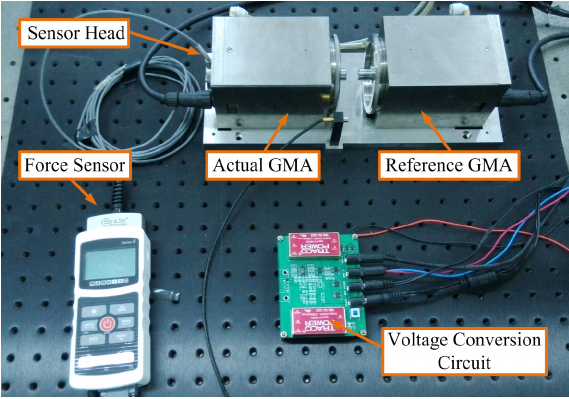
Figure 5. Photograph of experimental